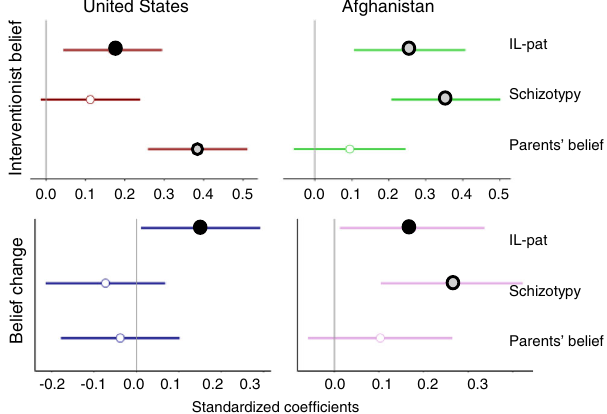
Fig. 2 Linear regression models to predict interventionist belief (IB) and belief change (BC) in the U.S. and Afghan samples. Signi fi cant β are indicated by fi lled circles. Black fi ll indicates P < 0.05 ( P = 0.036 for effect of IL-Pat on belief change in both samples; P = 0.009 for IL-Pat on IB in U.S. sample) and gray fi ll indicates P ≤ 0.001. Error bars represent 95%